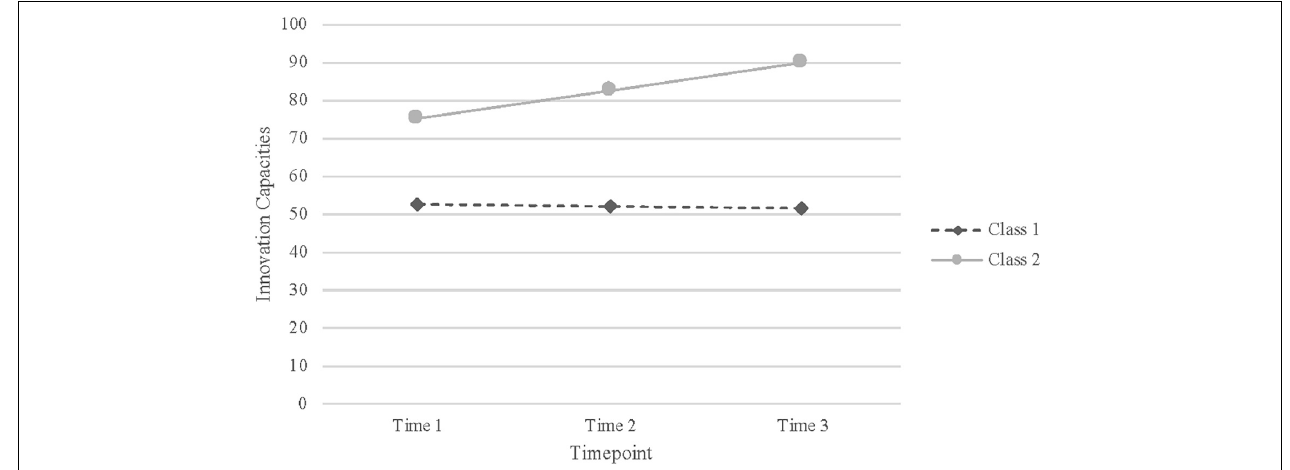
FIGURE 1 | Growth trajectories of students’ innovation capacities over time. Innovation capacities = Intercept + (Slope * Time). Dotted trend line indicates non-significant slope ( p > 0.05). TABLE 4 | Multinomial logistic regression results for predictors of membership in class 2. Odds Ratio S.E. Probability